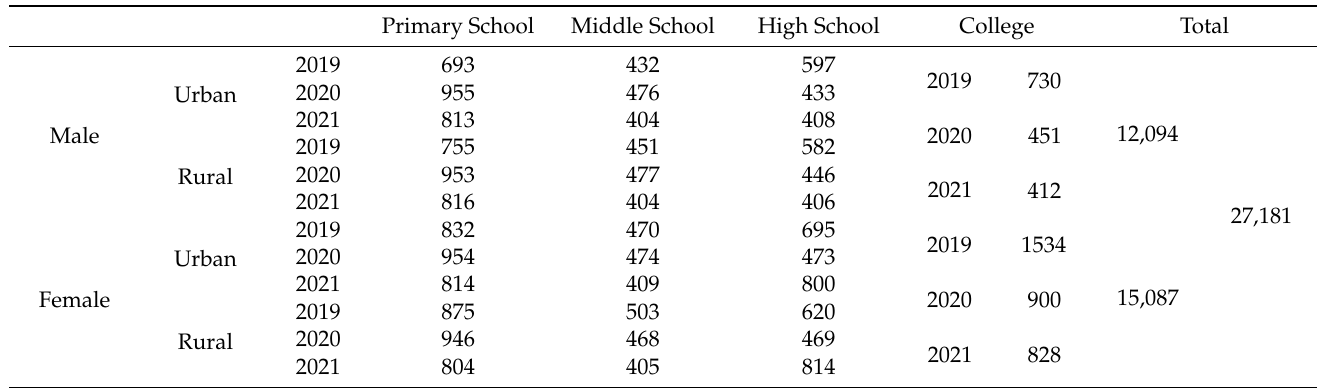
Table 1. Sample characteristics (n = 27,181).